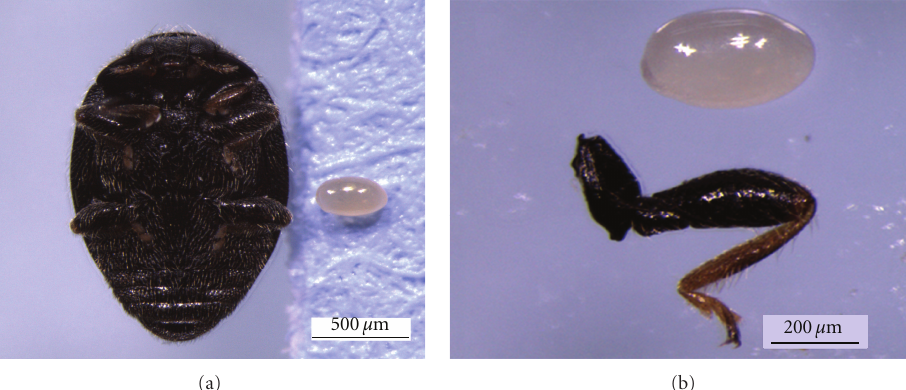
Figure 3: Ventral view of a mother with freshly laid egg (a) and dissected femur of another mother adjacent to one of her eggs